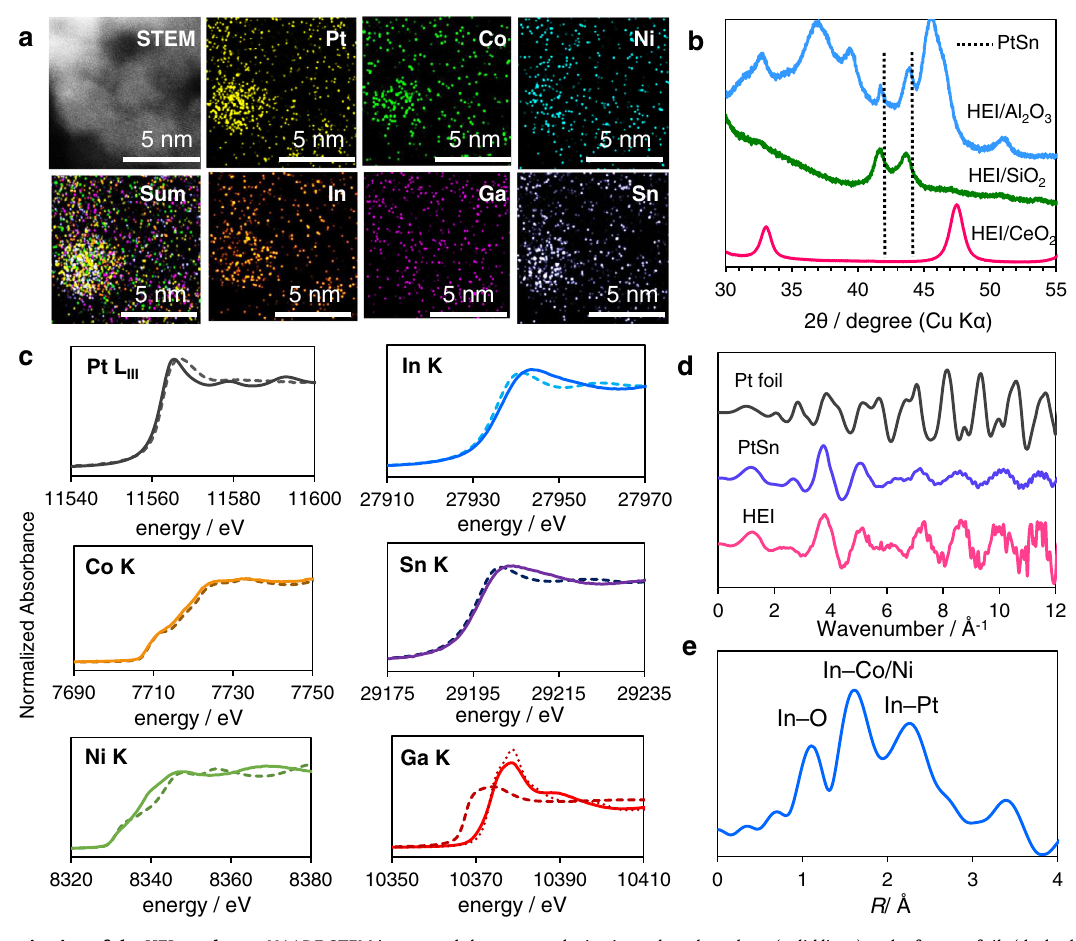
thein-situreducedcatalysts(solidlines)andreferencefoils(dashedlines)oroxides (dotted lined). d Pt L III -edge EXAFS oscillations of Pt foil, Pt – Sn and HEI/CeO 2 . e Fourier transform of the In K-edge EXAFS of HEI/CeO 2